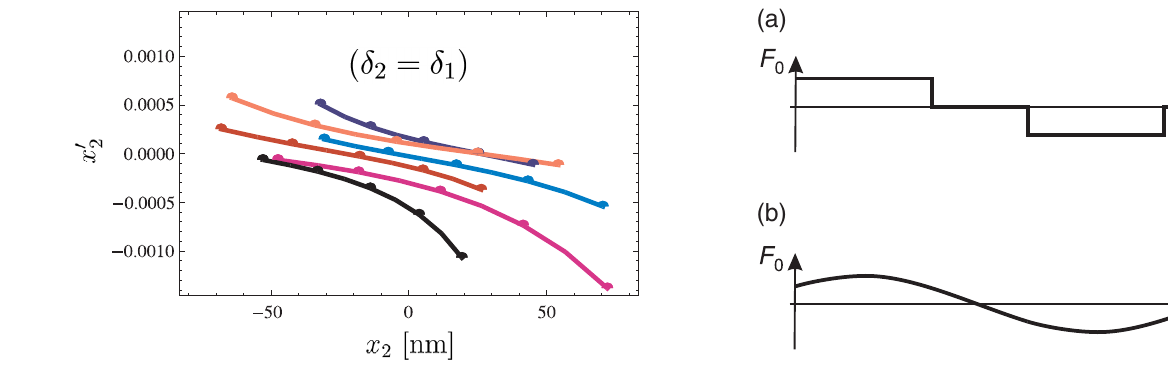
force.FIG. 10. The focusing properties of the O 5